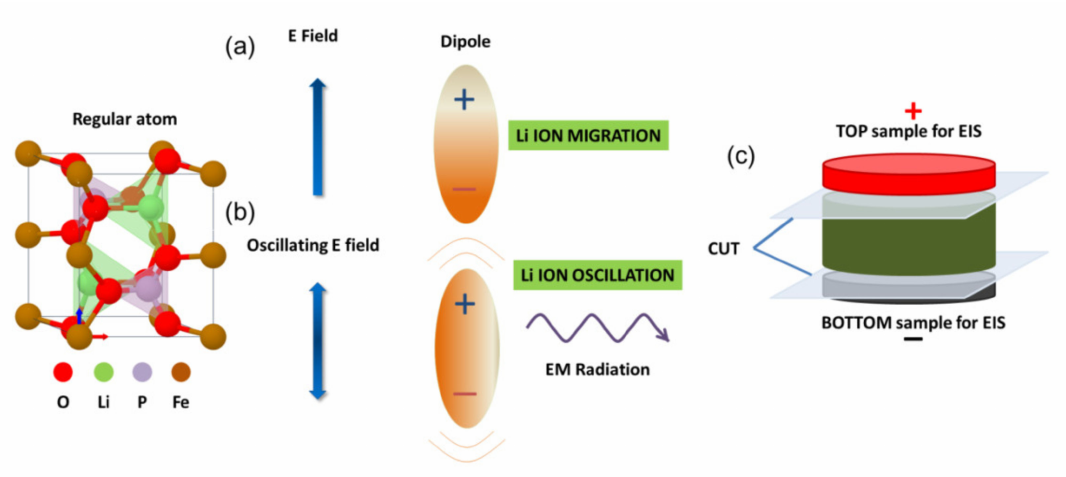
Figure 1. A schematic diagram of the SPS working setup using a comparison of Li-ion migration effects under ( a ) DC and ( b ) AC fields, ( c ) a cross-section of the sample for SEM, impedance spectroscopy, XPS and